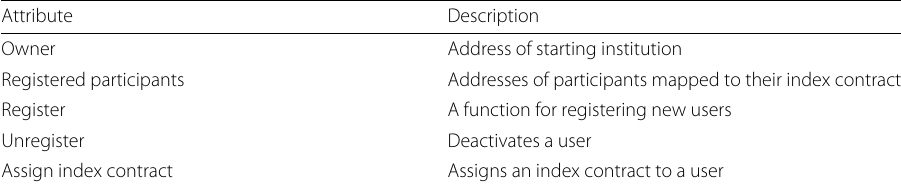
Table 2 Registrar-learning provider contract